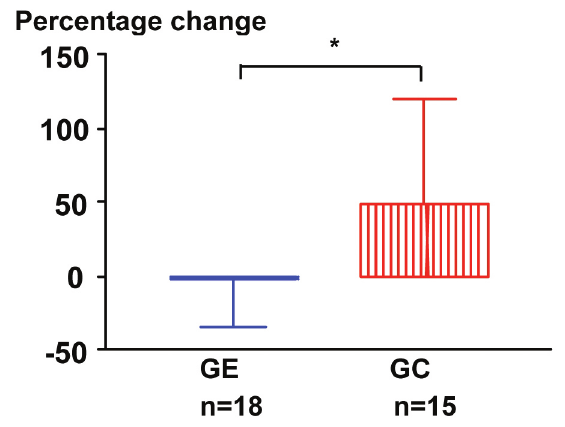
FIGURE 6 - Percentage change ± SD in correct responses on questionnaires between time 0 and 270 (days) in the normotensive experimental group (EGN) and normotensive control group (CGN). *p<0.006. EGN n=16 (16 patients of the normotensive experimental group attended the sessions to answer the questionnaire). CGN n=07 (7 patients of the normotensive control group attended the sessions to answer the